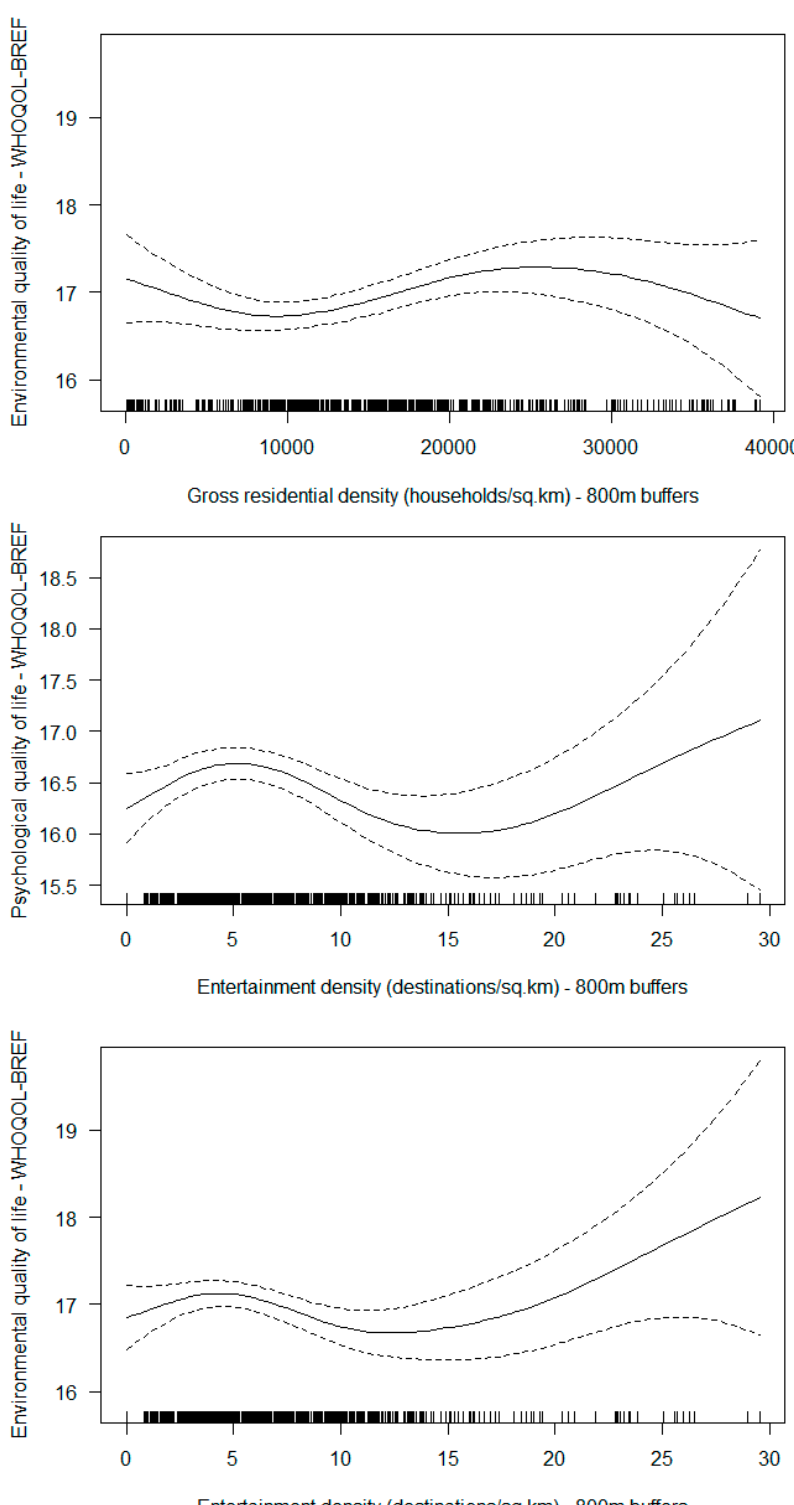
Figure 1. Independent curvilinear associations of neighbourhood physical attributes with quality of life (QoL). [Full lines represent point estimates of modelled scores of specific QoL dimensions, while the dotted lines represent their 95% confidence intervals.].